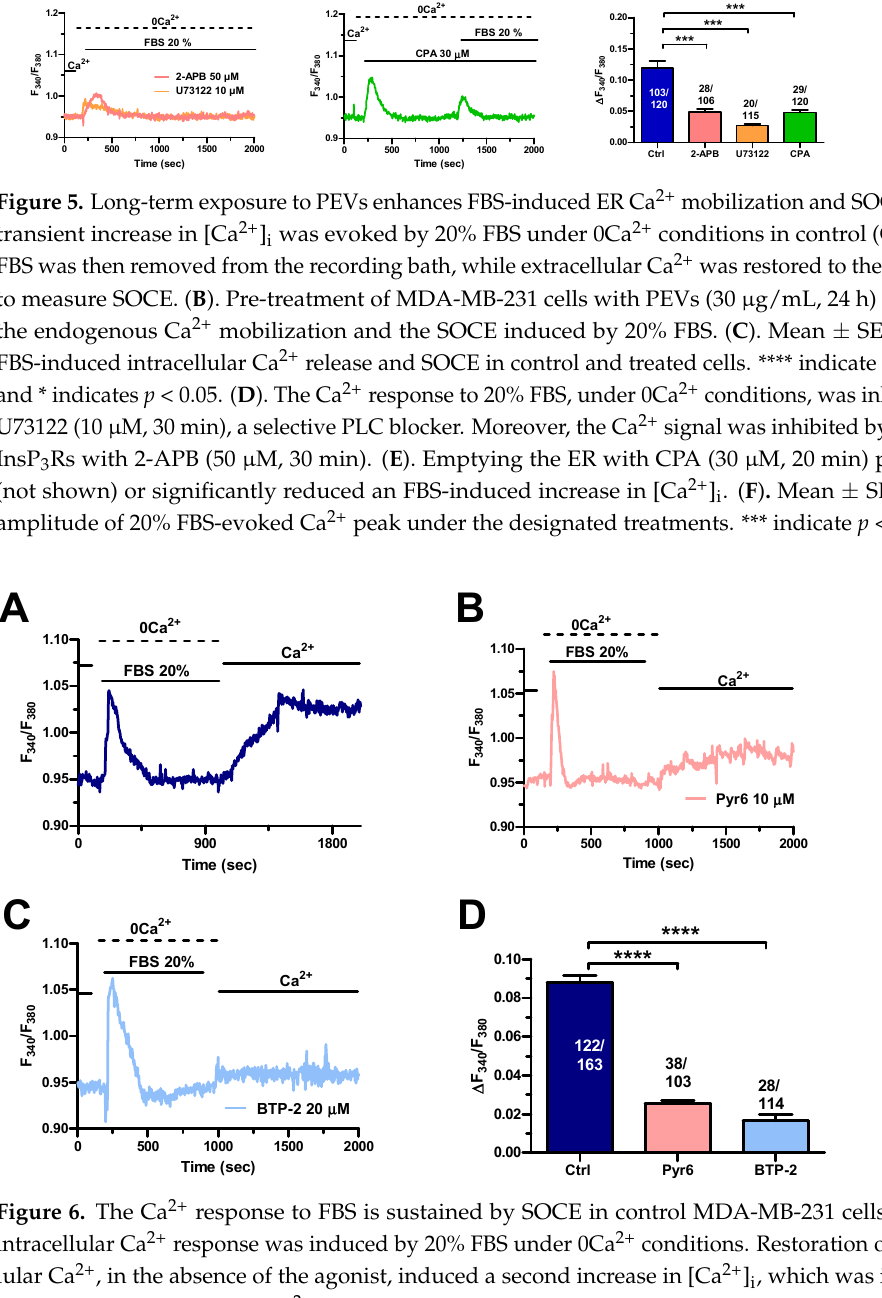
Figure 6. The Ca 2+ response to FBS is sustained by SOCE in control MDA-MB-231 cells. ( A ). An intracellular Ca 2+ response was induced by 20% FBS under 0Ca 2+ conditions. Restoration of extracel- lular Ca 2+ , in the absence of the agonist, induced a second increase in [Ca 2+ ] i , which was indicative of SOCE. ( B ). Extracellular Ca 2+ entry evoked by 20% FBS was suppressed or significantly reduced by blocking Orai1 with Pyr6 (10 μ M, 10 min). ( C ). Extracellular Ca 2+ entry evoked by 20% FBS was suppressed or significantly reduced by blocking Orai1 with BTP-2 (20 μ M, 10 min). ( D ). Mean ± SEM of the amplitude of Ca 2+ peak in cells under the designated treatments. **** indicate p < 0.0001.